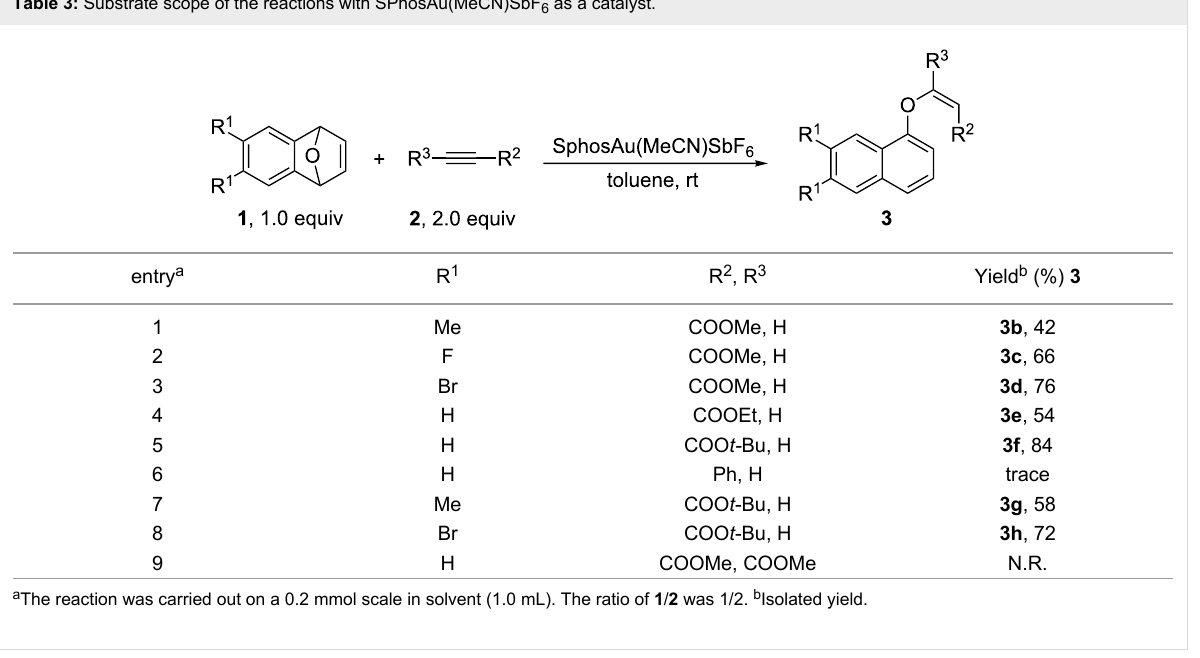
Table 3: Substrate scope of the reactions with SPhosAu(MeCN)SbF 6 as a